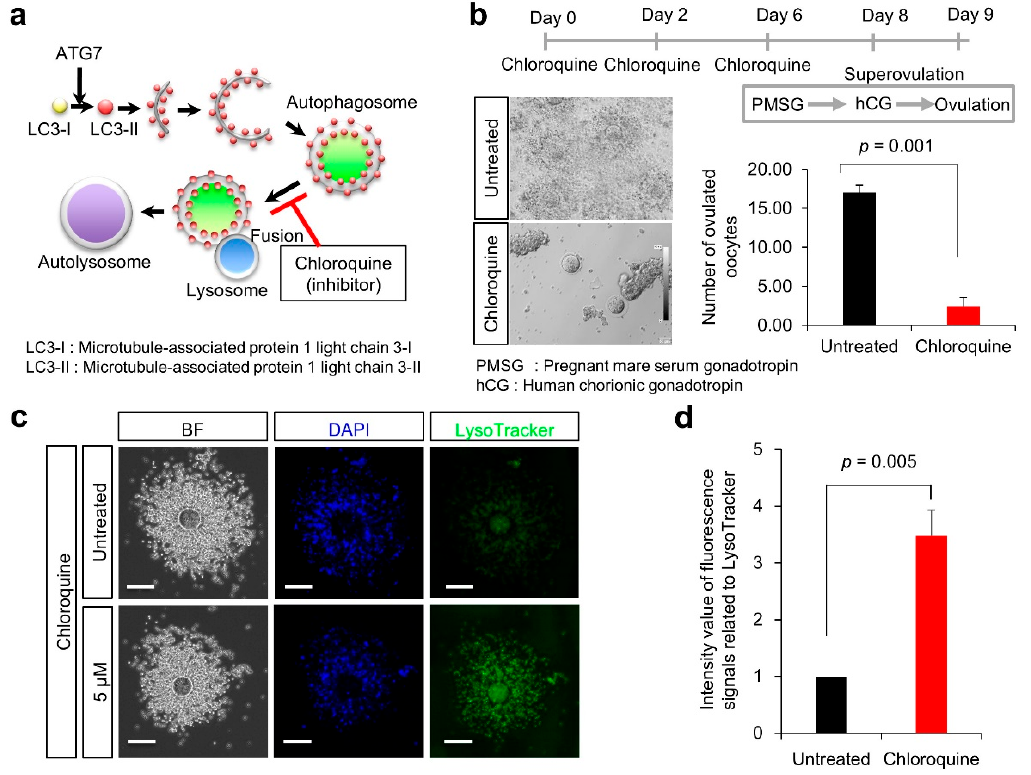
Figure 2. Effect of chloroquine treatment on ovulation rates in female mice. ( a ) Scheme of autophagy and participation of chloroquine in autophagosome-lysosome fusion during autophagy. ( b ) Experimental flow. As depicted in ( b ), chloroquine was injected into 7-week-old female mice (each group: n = 5). Ovulated oocytes were counted in superovulation-induced females with (red bar) and without chloroquine (black bar; Untreated). Values are expressed as the mean ± SE. ( c ) Lysosomal distribution. Cells were stained with LysoTracker Green DND26 (green). Scale bars, 100 µ m. ( d ) Quantification of fluorescent intensities of lysosomes (over 200 cells were counted in each case). The signal intensity in Untreated (black bar) was arbitrarily set at 1. The graph indicates the relative intensity value of fluorescence signals related to LysoTracker against that in Untreated (black bar). Values are expressed as mean ± SE.